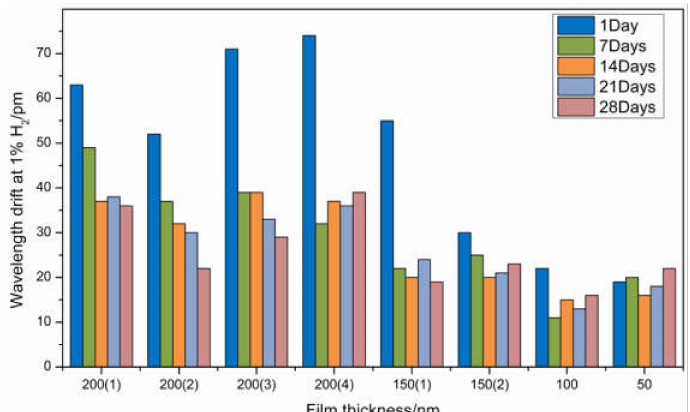
Figure 11. Wavelength drift of hydrogen sensors with different thicknesses at 1% H 2 . It can be seen from Figure 11 that the hydrogen sensor with the film thickness of 200 nm, coating speed of 62.5 µ m/s, and coating times of three times has the best durability and stable performance. Therefore, the sensor with a film thickness of 200 nm is selected as the test sensor in the follow-up experiment. In order to improve the accuracy of the experimental data, a new sensor was prepared. When the volume fraction of hydrogen in the gas chamber is 1.5%, we test and record with the same test method. The experiment was divided into four groups with three samples in each group, and the data were processed as average. The wavelength shift is shown in Figure 12. In the first test, the wavelength drift was above 65 pm, and the drift under 1% hydrogen concentration increased but did not reach the 50 pm/% growth rate. The reason is that the relationship between the expansion rate of palladium membrane and hydrogen concentration of 200 nm thickness is non-linear, and the drift change rate caused by palladium membrane expansion decreases. When the second measurement was carried out a week later, the wavelength drift generally decreased. The drift of the sensor is reduced by more than 1% of the concentration of hydrogen. The reason is that the high concentration of hydrogen is more destructive to the sensor, and the reduction of residual stress in the coating process is not enough to make up for the hydrogen embrittlement effect of palladium film. When the third measurement was carried out 14 days later, the wavelength drift of the sensor changed, but the fluctuation was small. The fourth and fifth measurements were carried out after 21 days and 28 days, respectively, and it was found that the wavelength drift was relatively stable at a certain value. This is due to the rupture of part of the palladium membrane caused by three hydrogen sensitivity tests, which release the residual stress during the preparation of the sensor. However, because the residual stress in the preparation process of the sensor is small, and there are still some residual thin films, it still has a certain ability to detect